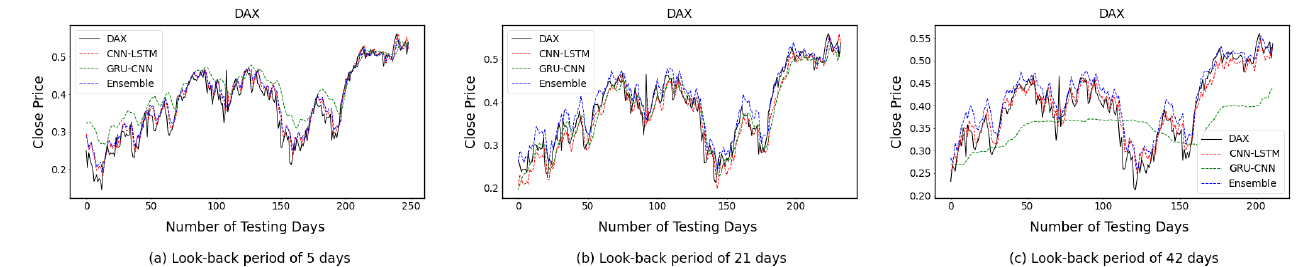
Figure 3. Comparison of true and predicted close prices of the DAX index between different look-back periods for one-time-step prediction over the period from 24 October 2014 through 31 December 2019.